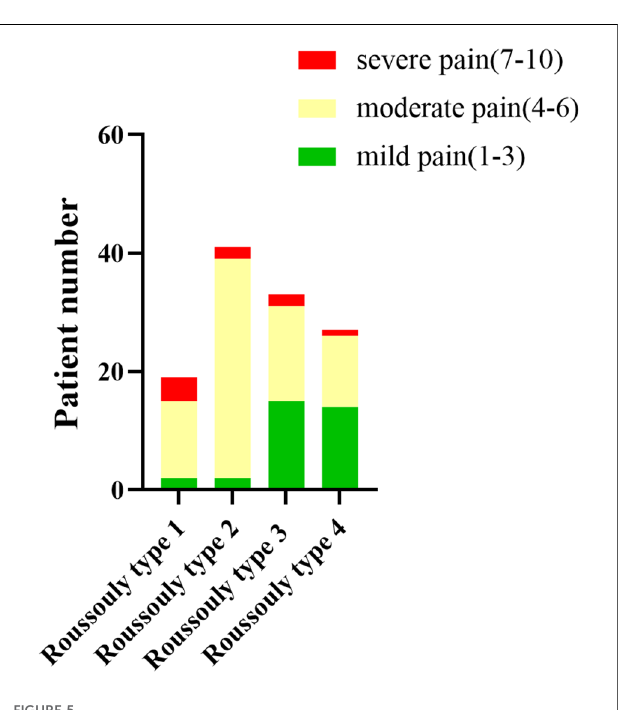
FIGURE 5 The PD patients with different pain rating classi fi ed with Roussouly